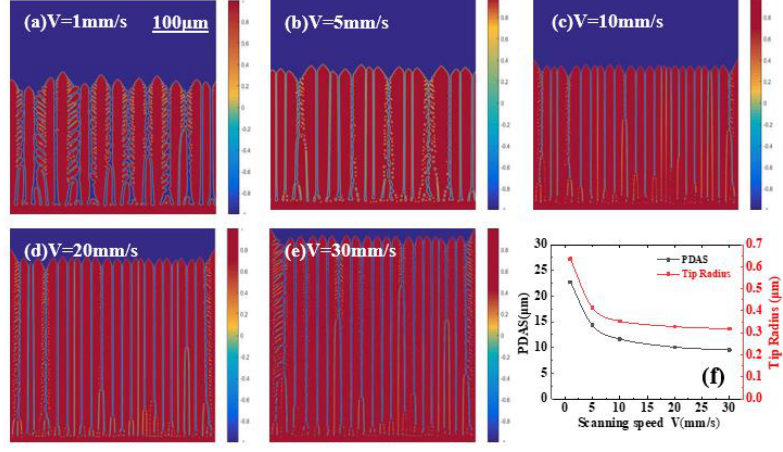
Figure 7. Dendrite morphology analysis at different laser scanning rates. ( a ) V = 1 mm/s, ( b ) V = 5 mm/s, ( c ) V = 10 mm/s, ( d ) V = 20 mm/s, ( e ) V = 30 mm/s, ( f ) Influence of scan speed on dendrite arm spacing and tip radius.